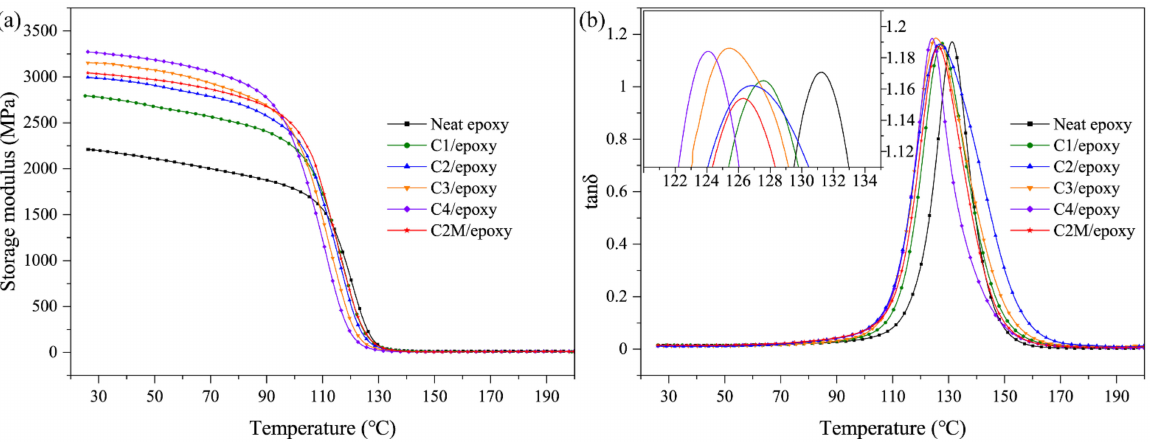
Figure 4. Dynamic mechanical properties of neat epoxy, ACSF/epoxy composites and MXene functionalized ACSF/epoxy composites: ( a ) storage modulus and ( b ) loss angle tangent.